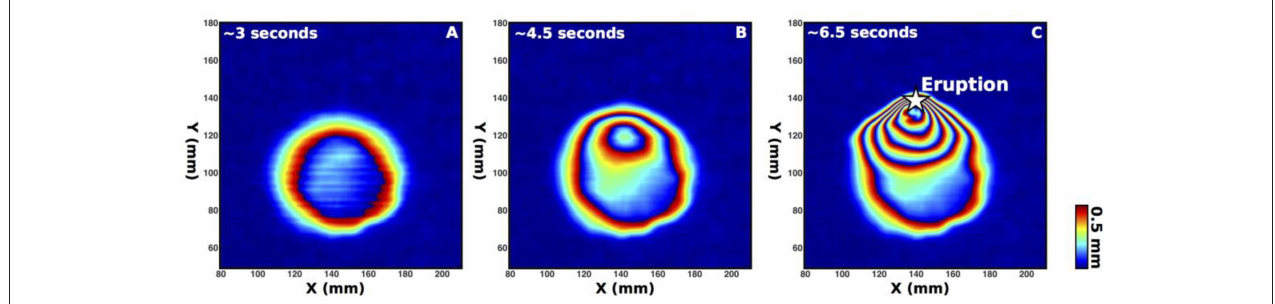
FIGURE 4 | (A,B) 1 DEM before eruption for a representative dyke (A) and cone sheet (B) experiment (uplift in mm). White and black crosses show the successive locations of the centers (C) of the uplifted area, and of the maximum uplifts (M), respectively. (C,D) Plots of the successive vectors respective maps, (A,B) , from the early (dark blue) to the final stages (dark red). A black star locates the eruption points. Final points of maximum uplifts almost locate the eruptions.